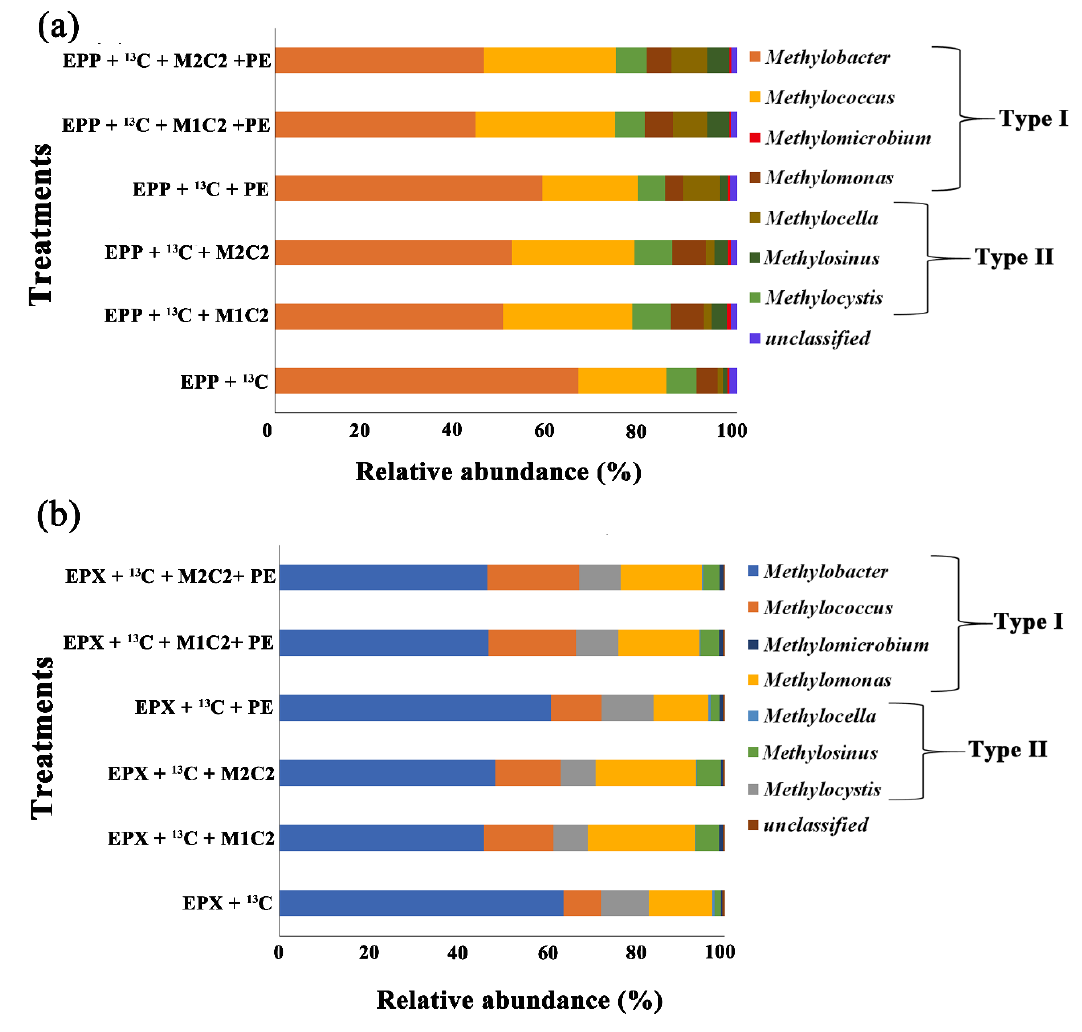
Figure 10. High-throughput pmoA gene sequencing showing relative abundance of pmoA in ( a ) epiphyton and ( b ) epixylon derived from 13 C fraction of DNA obtained by gradient centrifugation of treatments with Pb 2 + (M1) and Cd 2 + (M2) at a concentration of 50 mg L − 1 (C2) and in combination with PE.